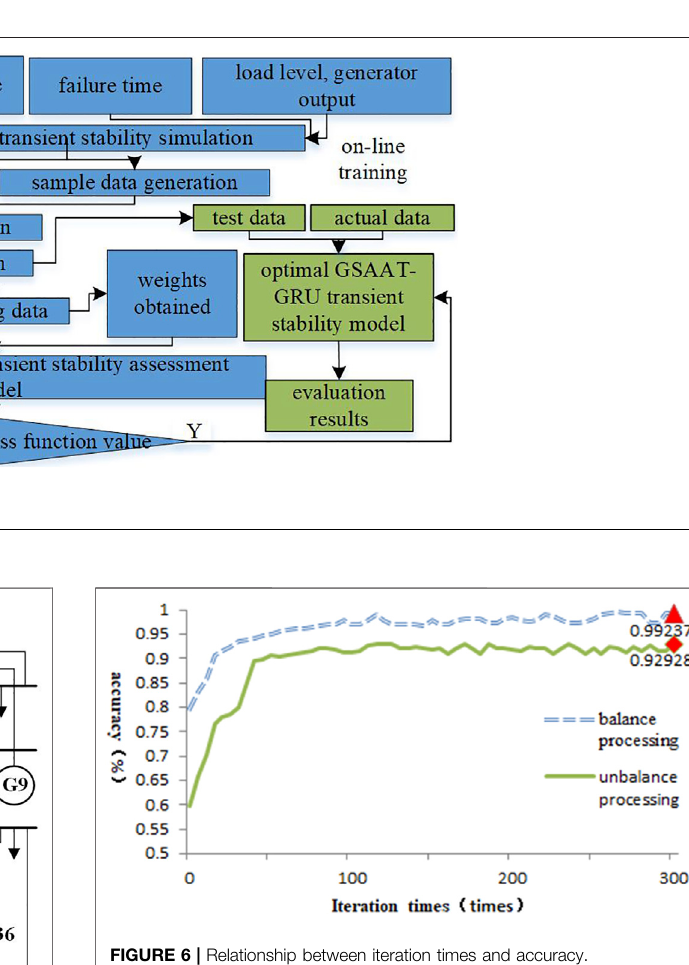
FIGURE 6 | Relationship between iteration times and